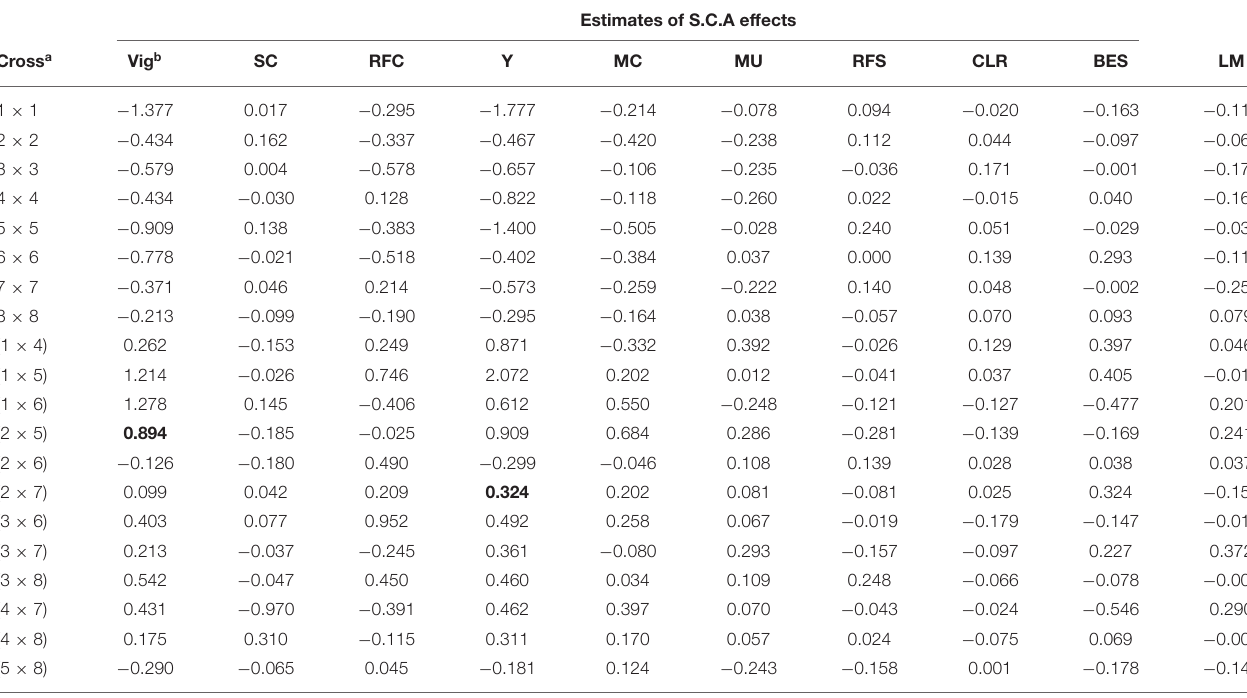
TABLE 8 | Estimated of the effects of specific combining ability (SCA) of 12 hybrids (in parentheses) and 8 parents based on the means of 10 evaluated agronomic traits. Estimates of S.C.A